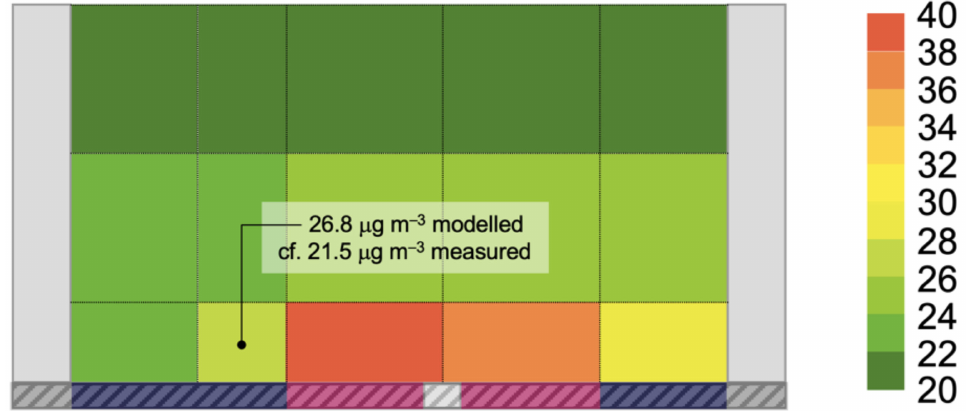
Figure 10. Modelled 2012 annual mean PM 2.5 ( µ g m − 3 ) beside Marylebone